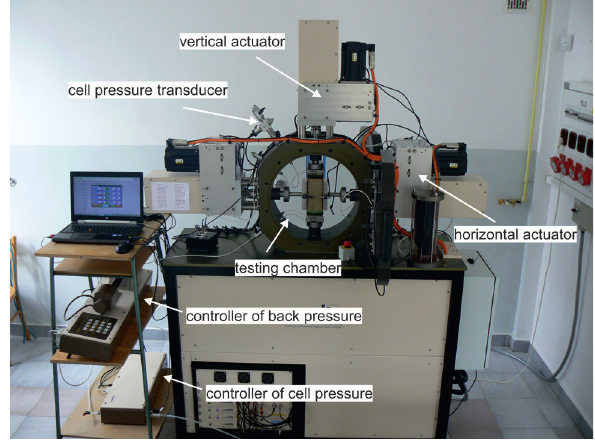
Figure 6: Components of EMTTA, used in the study.